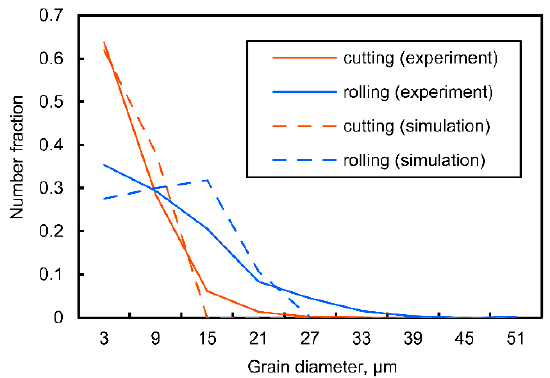
Figure 14. Grain size distribution after heat treatment at 600 °C for 1 min.